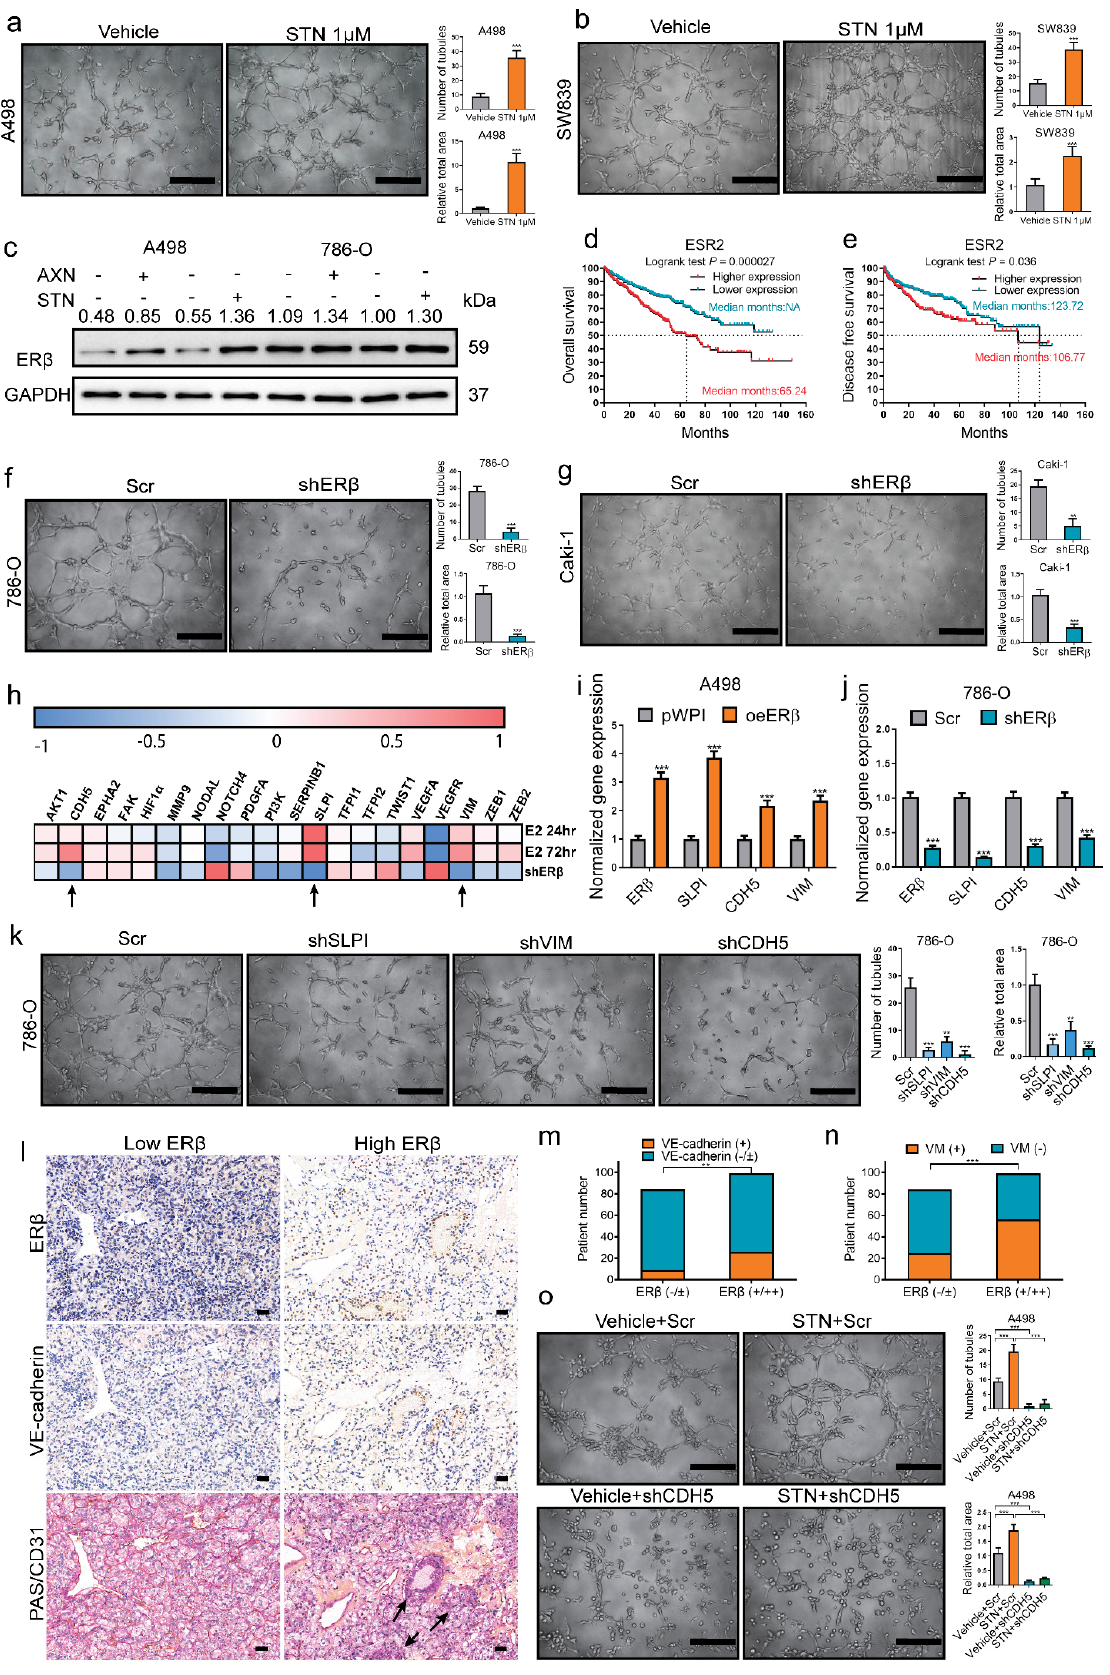
Figure 1. VM formation in RCC induced by sunitinib treatment via ER β up-regulation could be blocked by silencing VE-cadherin. ( a , b ) Matrigel culture system for tube formation assay (images, left) and quantification (right). After sunitinib (STN) treatment (1 μ M) for one week, the A498 ( a ) and SW839 ( b ) cells demonstrated increased ability to form polygonal structure both by morphol- ogy recognition and by tubule number and area quantification. ( c ) Western blot showed increased levels of ER β in both 786-O and A498 cells after sunitinib (1 μ M) treatment and axitinib (1 μ M) treatment. ( d , e ) TCGA data analysis between ER β (ESR2) expression and ccRCC patients’ overall ( d ) and disease-free survival ( e ). ( f , g ) Knocking down ER β in 786-O ( f ) and Caki-1 ( g ) cells severely debilitated their ability to form tubules; quantifications are on the right. ( h ) RNA-Seq analysis of VM-related genes after E2/shER β treatment. ( i , j ) QPCR confirmation of SLPI, VIM, and CDH5 after overexpressing of ER β (oeER β ) in A498 ( i ) cells or knocking down ER β (shER β ) in 786-O ( j ). ( k ) Comparison of effect of silencing SLPI (shSLPI), VE-cadherin (shCDH5), and Vimentin (shVIM) in inhibiting VM. ( l ) Representative images of ER β (upper panels), VE-cadherin (middle panels), and PAS/CD31 (lower panels) IHC double staining in ccRCC samples. Black arrow: VM. ( m ) VE-cad- herin positive ratio comparison between ER β ( − /±) or (+/++) tumors of ccRCC patients. ( n ) VM pos- itive ratio comparison between ER β ( − /±) or (+/++) tumors. ( o ) Knocking down VE-cadherin (shCDH5) interrupted the sunitinib-enhanced tube formation. Scale bar, 20 μ m, quantifications on the right . Data is presented as mean ± SEM. ** p < 0.01, *** p < 0.001. 2.2. The miRNA-125-5p Is Involved in Mediating ER β ’s Modulation of VE-Cadherin To determine how ER β regulates VE-cadherin mRNA, 786-O cells were starved of estrogen contact by incubating them in 5% charcoal-dextran-stripped (CDS) FBS DMEM media for 4 days, then treated with 10 nM estradiol (E2) for 6, 12, 48, or 72 h. The qPCR results showed that mRNA of VE-cadherin did not increase in 6, 12, or even 24 h, whereas it significantly increased at 48 and 72 h (Figure 2a). We speculate that the regulation might be indirect post-transcriptional regulation, and ER β may function via non-coding RNA regulatory mechanisms. We hypothesize that miRNAs, which have been reported to down-regulate mRNA post-transcriptionally [31], may be involved. To test the hypothe- sis, we cloned the 3 ′ UTR of VE-cadherin (CDH5) into psiCHECK2 luciferase plasmid (Figure 2b). The relative luciferase activity decreased significantly after knocking down